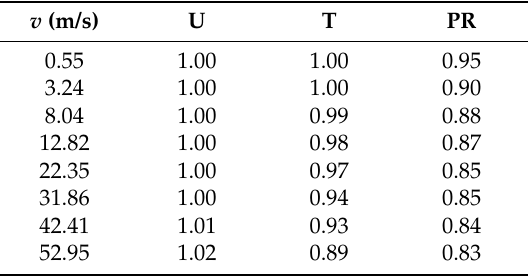
Table 2. Instrument coefficient.